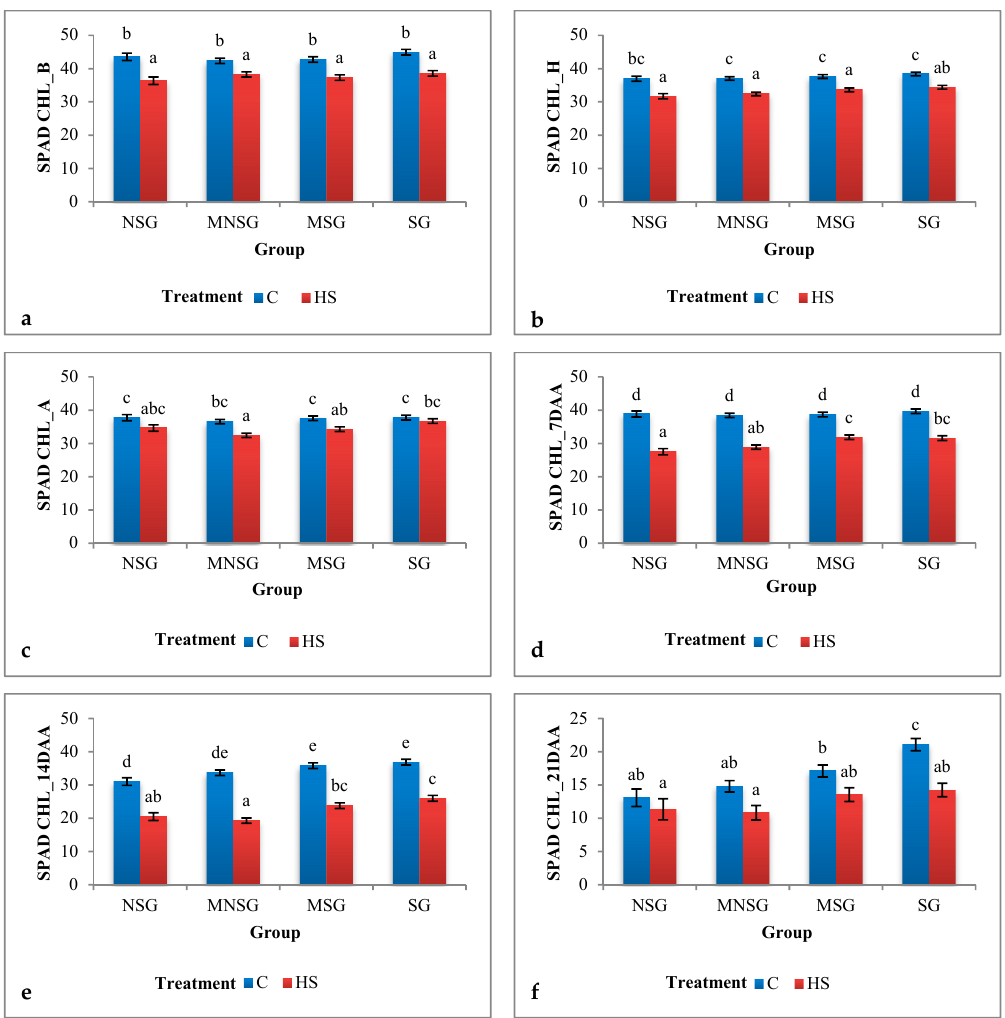
Figure 1. Heatmap depicting the normalized difference vegetative index (NDVI) in the non-stay-green (NSG), moderately non-stay-green (MNSG), moderately stay-green (MSG), and stay-green (SG) genotypes at different developmental stages under control condition. The blue color represents the maximum value for the NDVI and the red color indicates the minimum value for the NDVI.